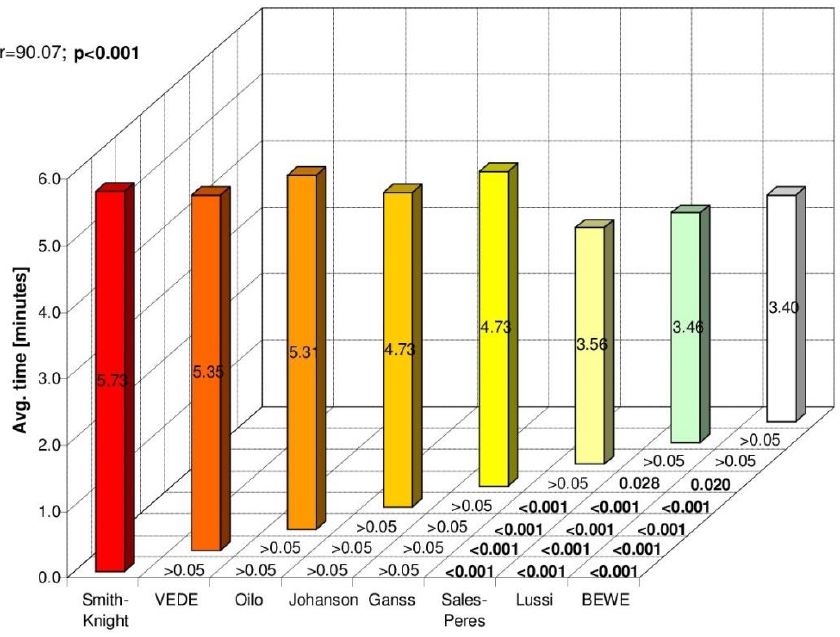
Figure 1. The result of the Friedman test in the assessment of the significance of the differences in the test time using individual wear/erosion indexes in the study group.